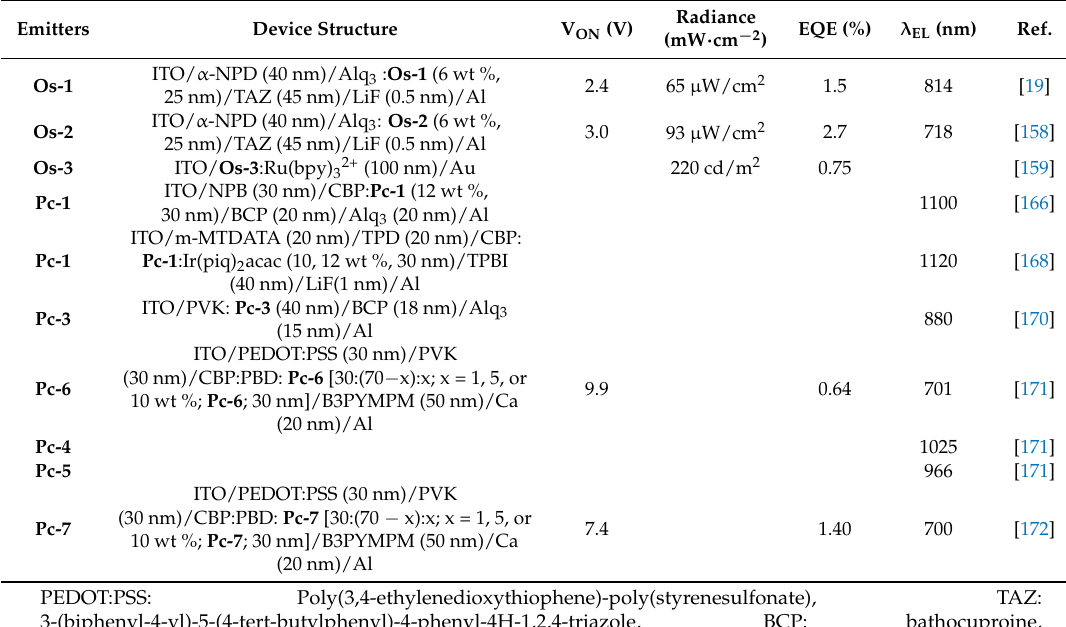
Table 8. Summary of electroluminescent properties of organic light-emitting diodes (OLEDs) fabricated with various